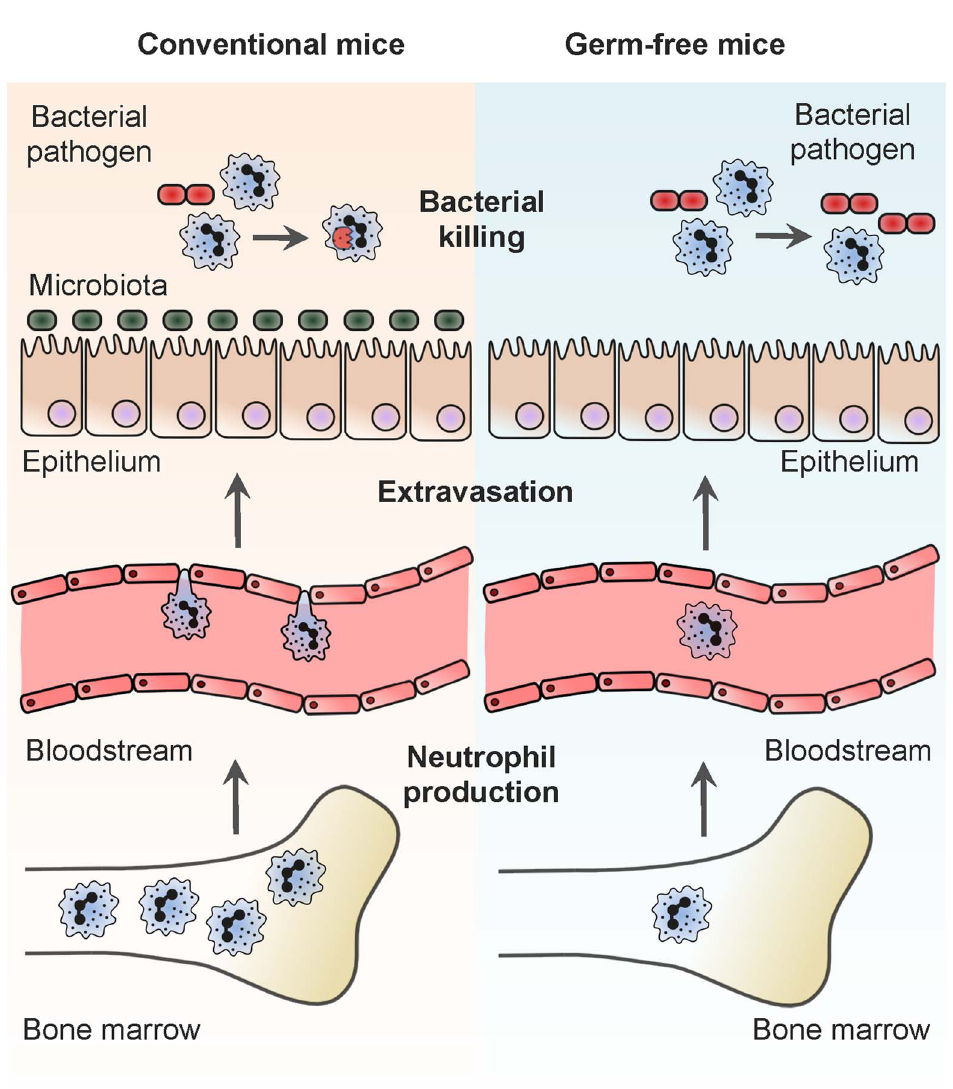
Figure1.Systemicregulationofneutrophilproductionandfunctionbythemicrobiota. Thissummarizesthestagesinneutrophilproduction and function that are known to be regulated by the microbiota. Conventional mice are those colonized by the microbiota and germ-free mice are those that have been born and raised in a sterile environment and thus not colonized by any live microbial communities. Neutrophil production: